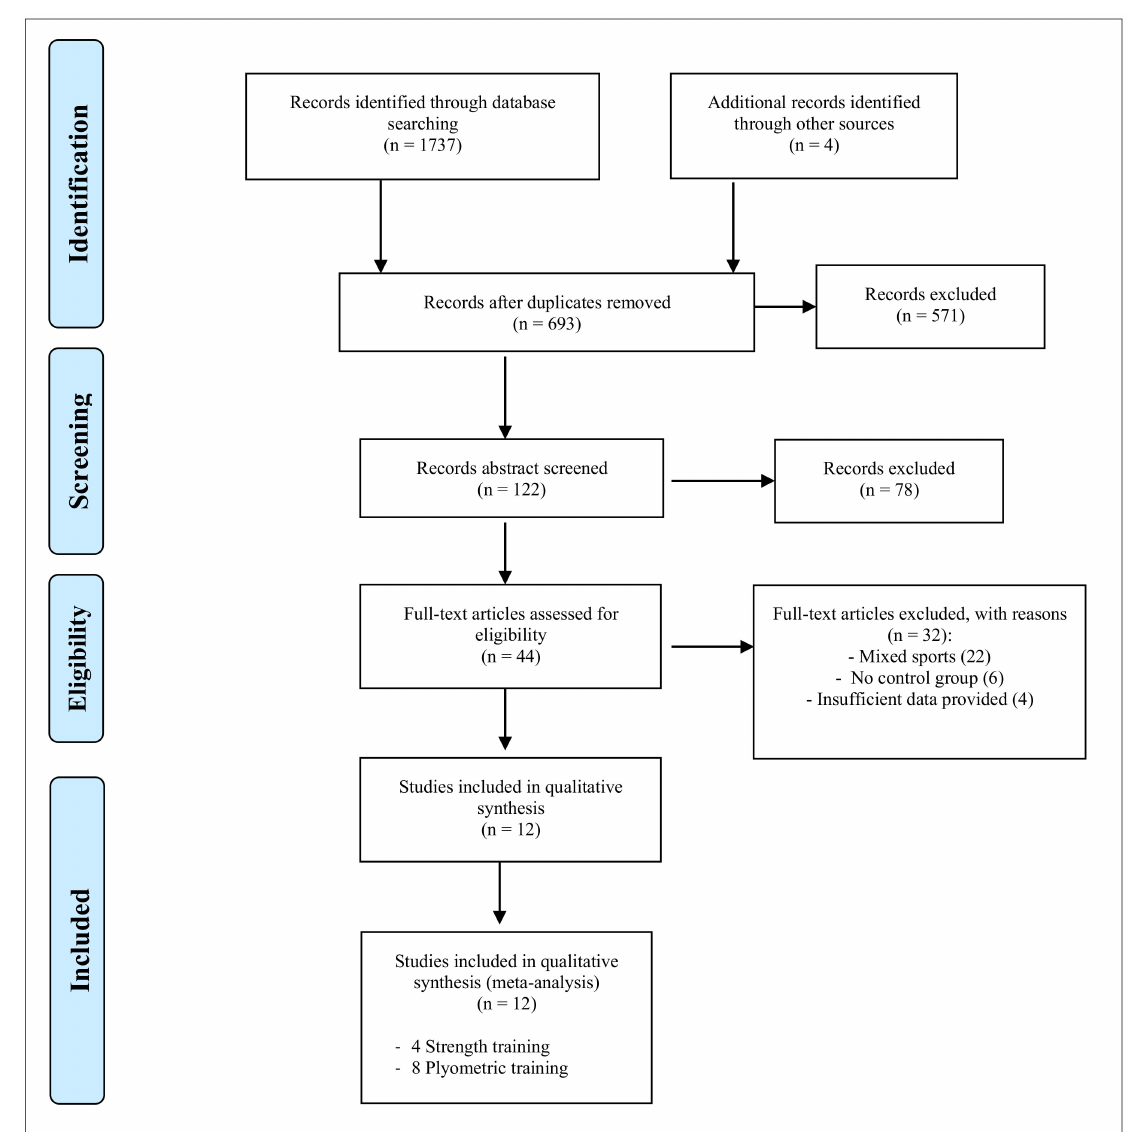
Figure 1. PRISMA flow chart for inclusion and exclusion of